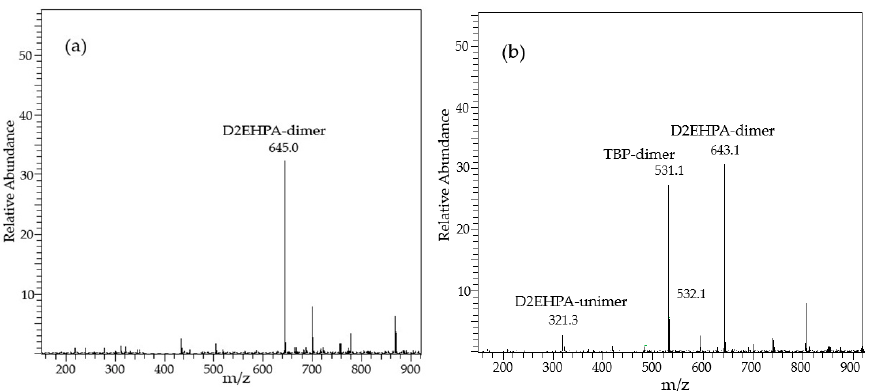
Figure 7. Electrospray Ionization (ESI) mass spectra of ( a ) D2EHPA and ( b ) mixture of D2EHPA and TBP (7:3).